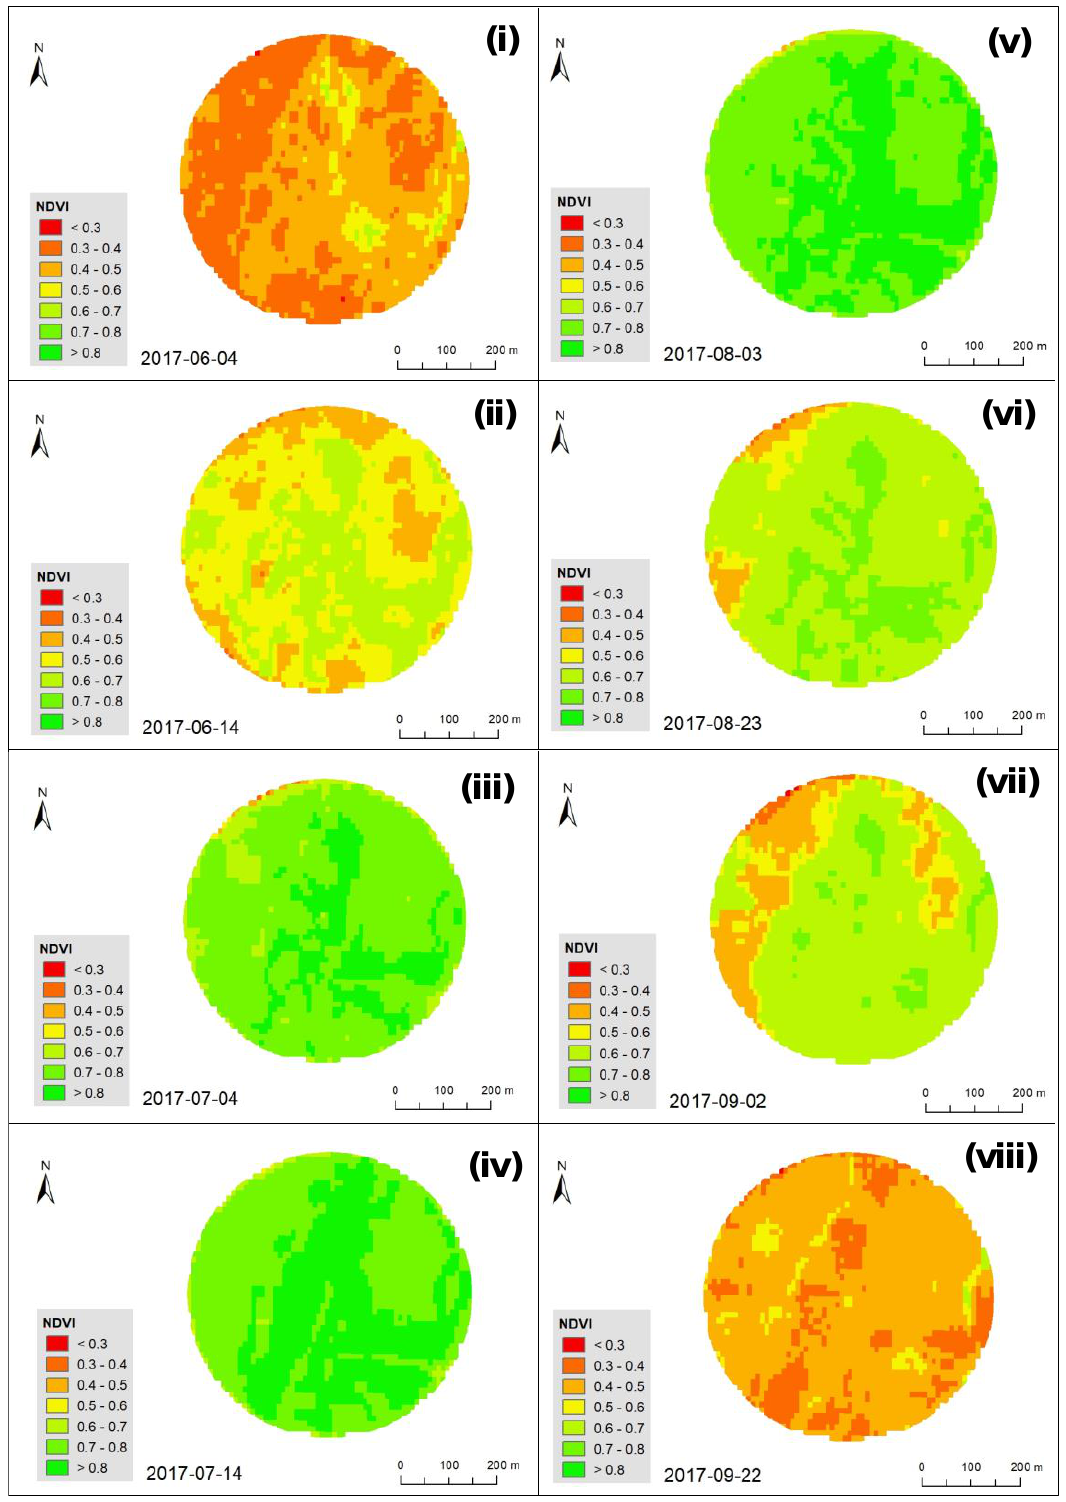
Figure 7. Normalized di ff erence vegetation index (NDVI) maps of the “Eucalyptus” field in di ff erent dates (maps ( i )–( viii )), between June and September